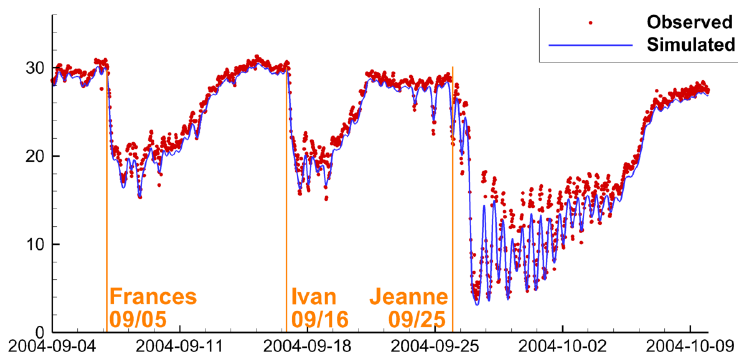
Figure 9. Comparison of simulated and observed salinity Cat Point station (NG domain), orange vertical lines indicate land fall times of the three storms: Frances, Ivan, and Jeanne.